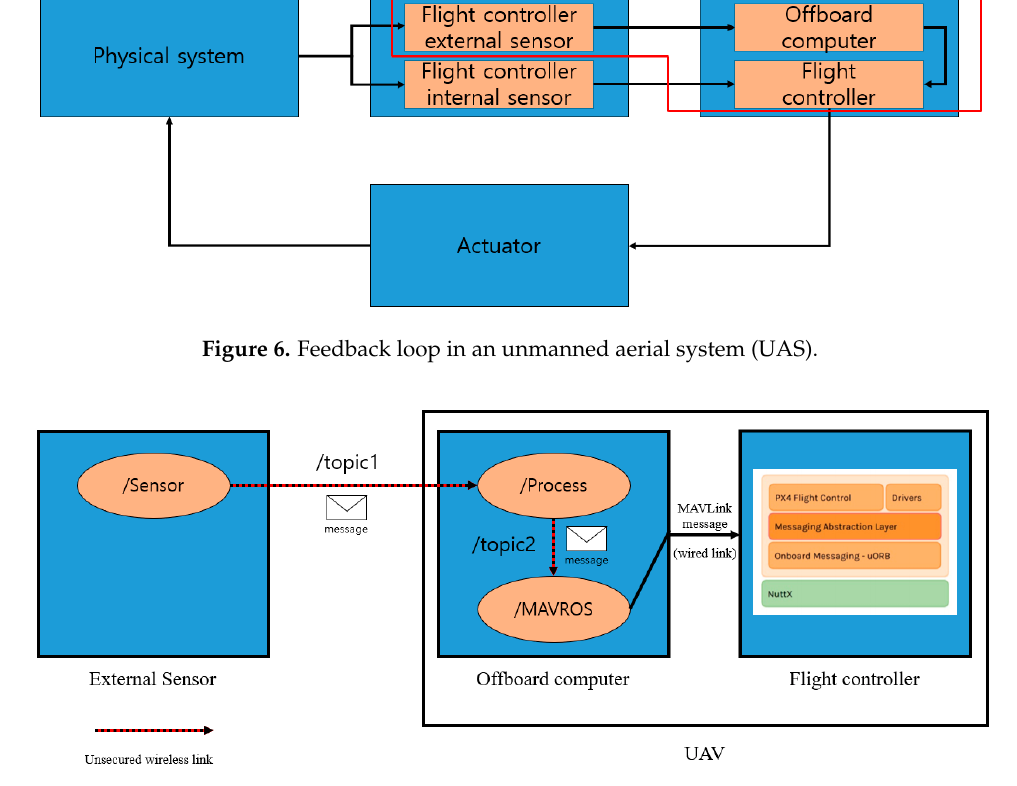
Figure 7. System Model of UAV with ROS.